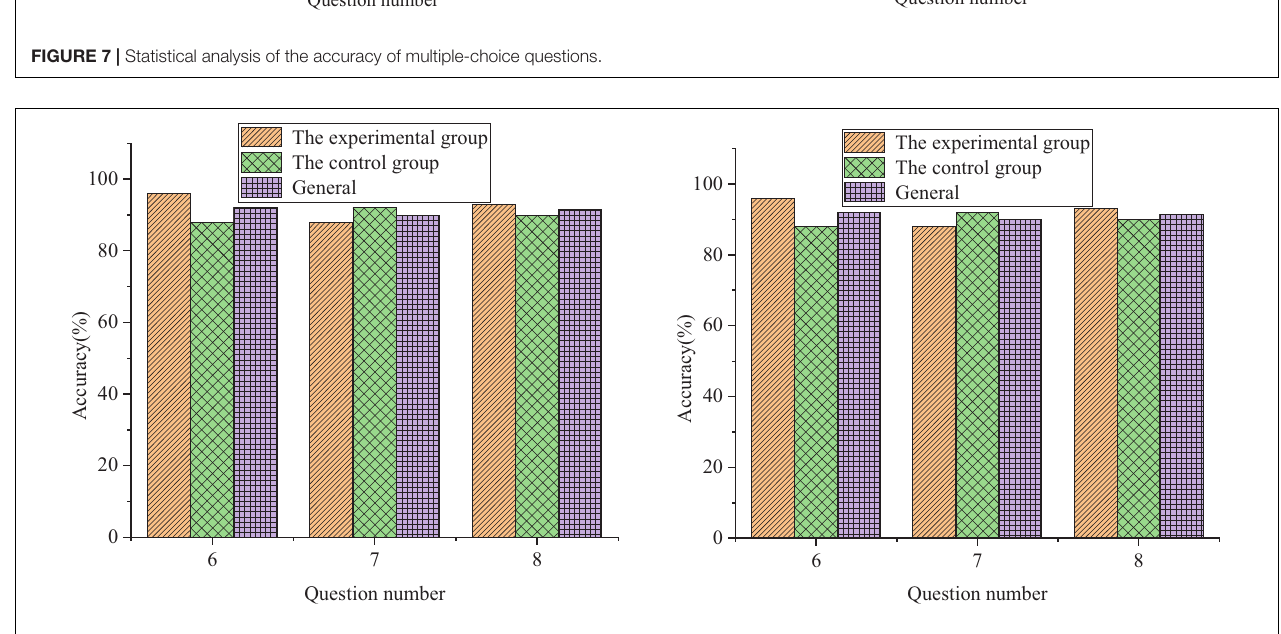
FIGURE 8 | Statistics of the accuracy for the calculation and short answer